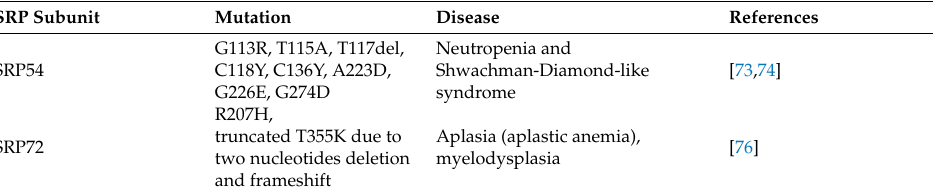
Table 1. Disease-associated mutations in SRP